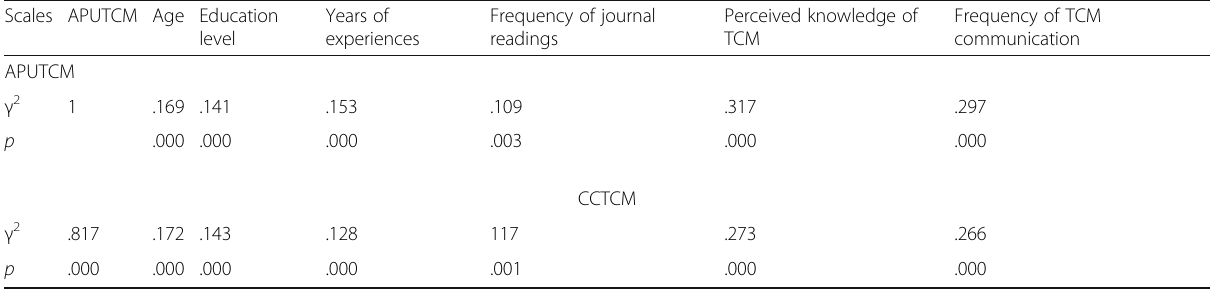
Table 4 Correlations between variables and scale Scales APUTCM Age Education